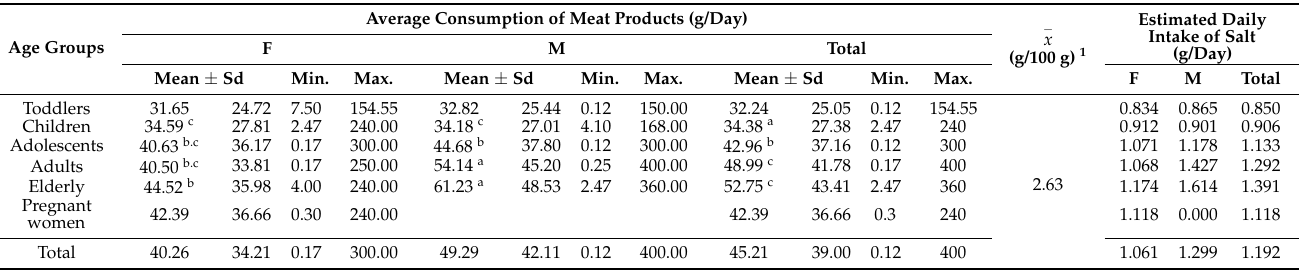
Table 4. Average consumption of meat products and estimated daily intake of salt from meat products per age and gender